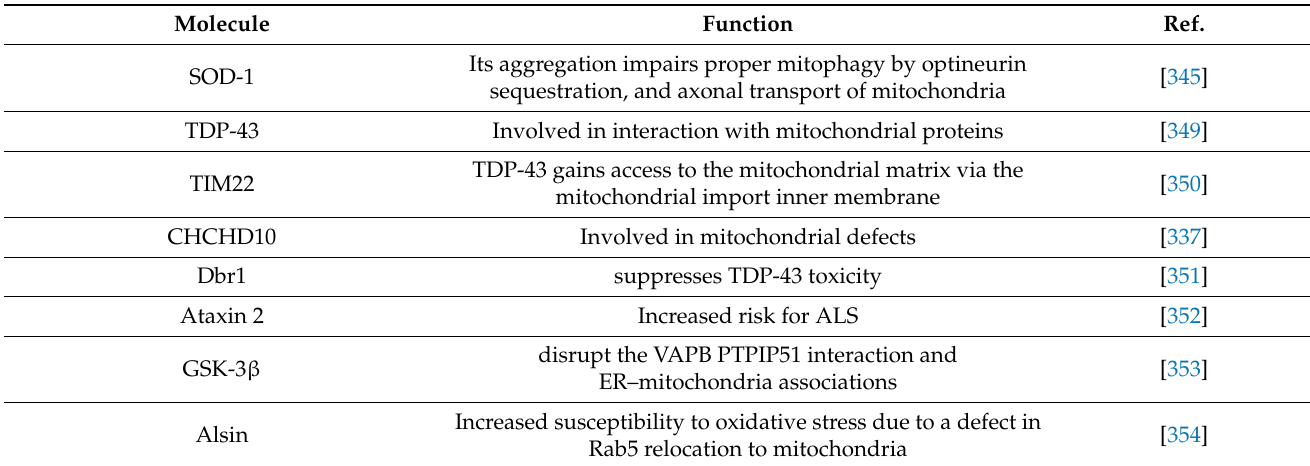
Table 6. Proteins involved in mitochondrial dysfunction in ALS.